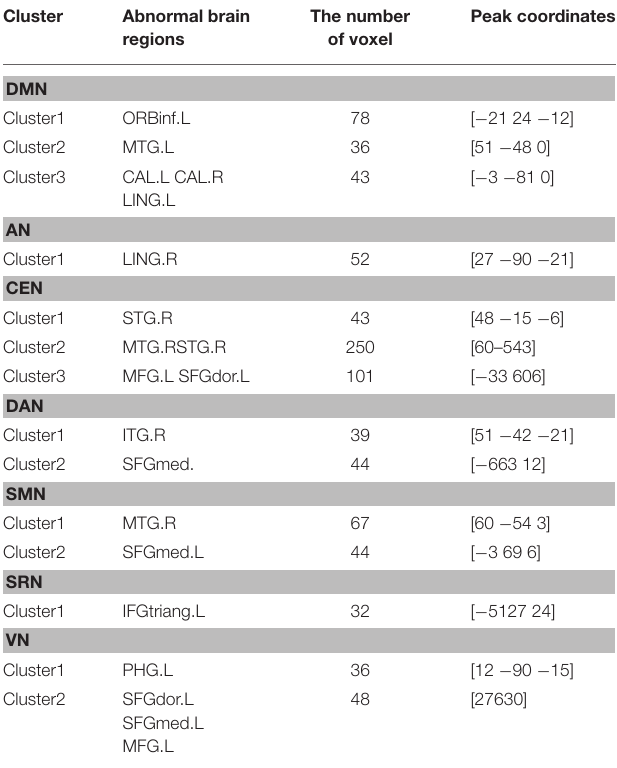
TABLE 2 | Clusters with significant differences of the functional connectivity in RSNs of MCI. Cluster Abnormal brain regions